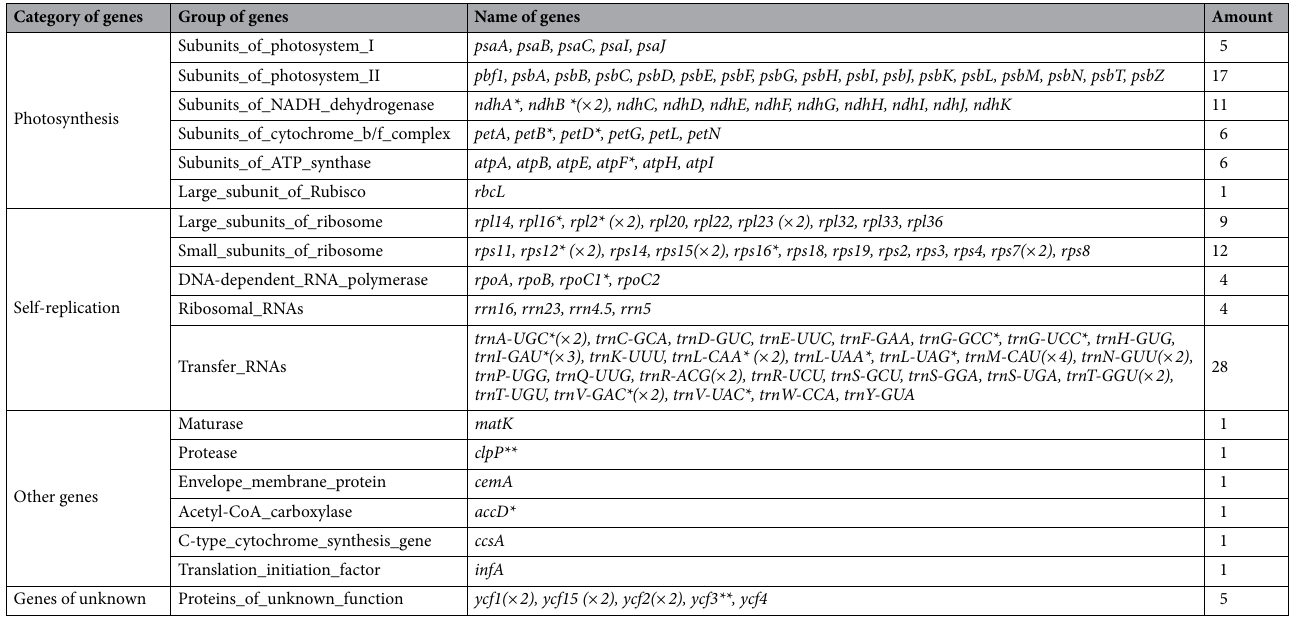
Table 2. List of genes annotated in the chloroplast genomes of ten Ligustrum species in this study. *Gene contains one intron; **Gene contains two introns; (× 2) indicates the number of the repeat unit is 2.